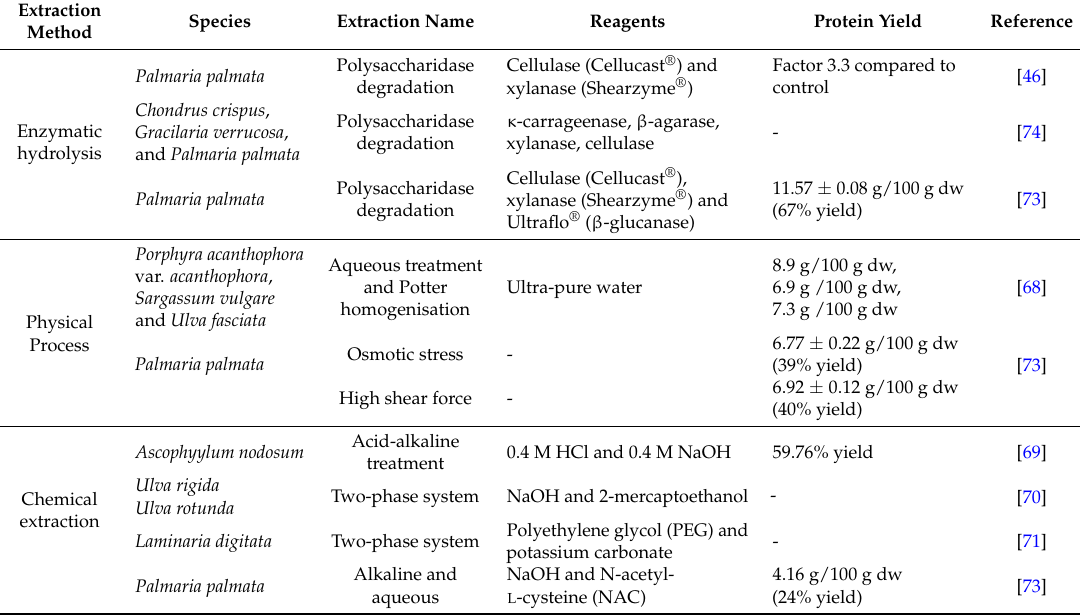
Table 1. Conventional pre-treatment cell disruption methods and extraction methods for precipitating proteins from seaweed. Dry weight;